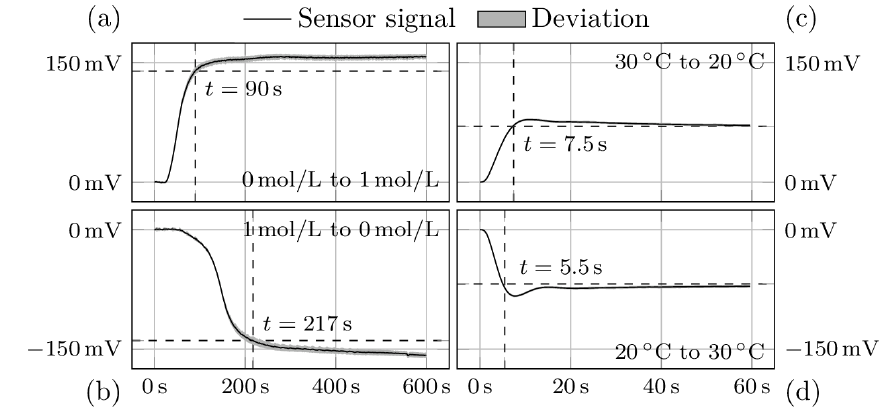
Figure 4. Response of the sensor to changes in concentration (a, b) and temperature (c, d) . While the measurement signal increases with increasing concentration (a) , it decreases with increasing temperature (d)